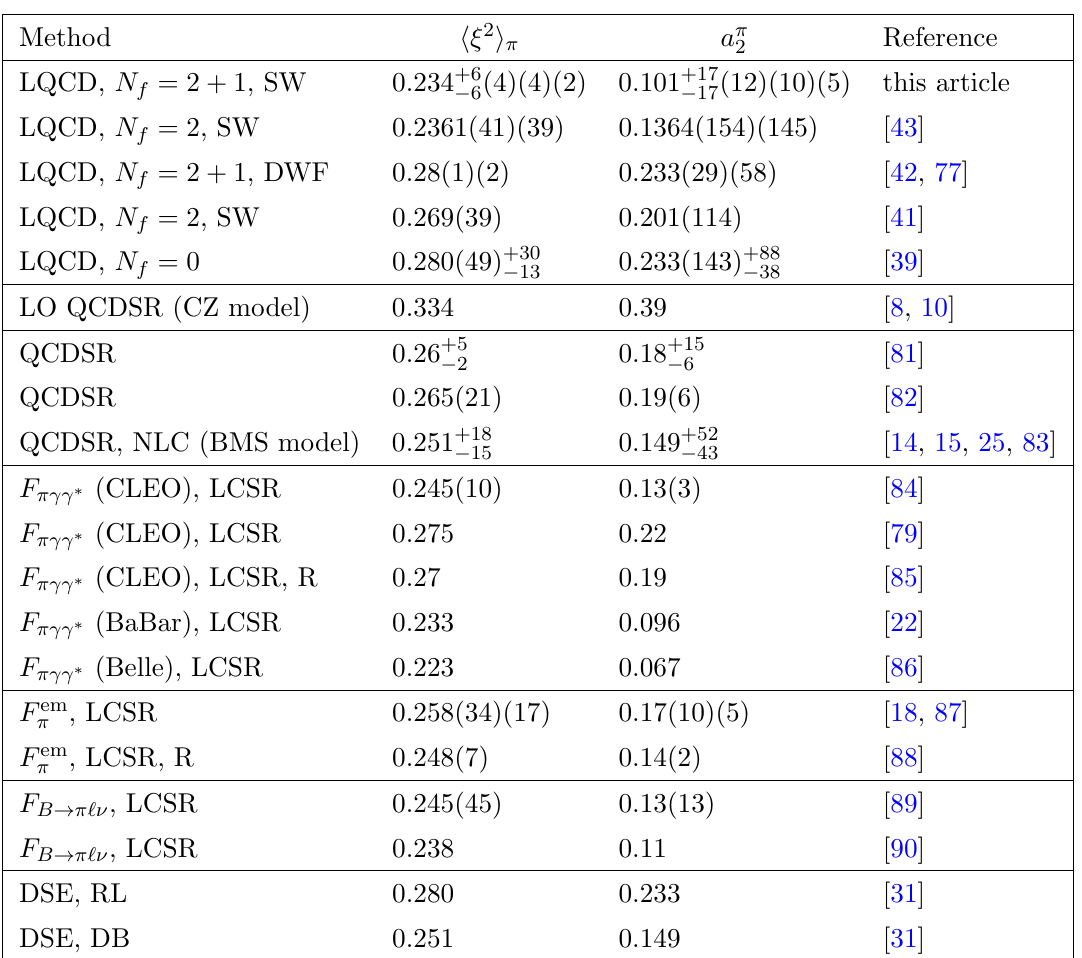
Table 4 . The second moment of the pion LCDA at the MS scale (cid:22) = 2 GeV. The CZ model (cid:12)xes a (cid:25) = 2 = 3 at the low scale (cid:22) ’ 500 MeV; for a discussion of the extrapolation to higher scales 2 see ref. [79]. The abbreviations stand for: LQCD: lattice calculation; N f = 2(+1):